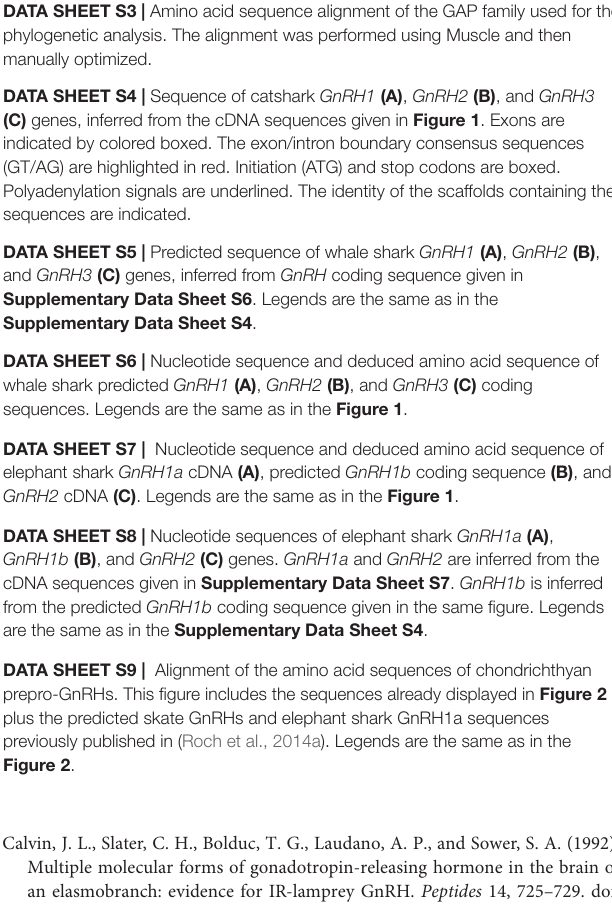
colored: in blue for GnRH1, orange for GnRH2 and green for GnRH3. Chondrichthyan species are in red. DATA SHEET S1 | Protein sequences of prepro-GnRHs used for phylogenetic analysis and their accession numbers. Sequences revealed in the present study are in red. GnRH and GAP sequences are highlighted in green and yellow, respectively. DATA SHEET S2 | Amino acid sequence alignment of the GnRH family used for the phylogenetic analysis. The alignment was made using MAFFT and then manually optimized. DATA SHEET S3 | Amino acid sequence alignment of the GAP family used for the phylogenetic analysis. The alignment was performed using Muscle and then manually optimized.